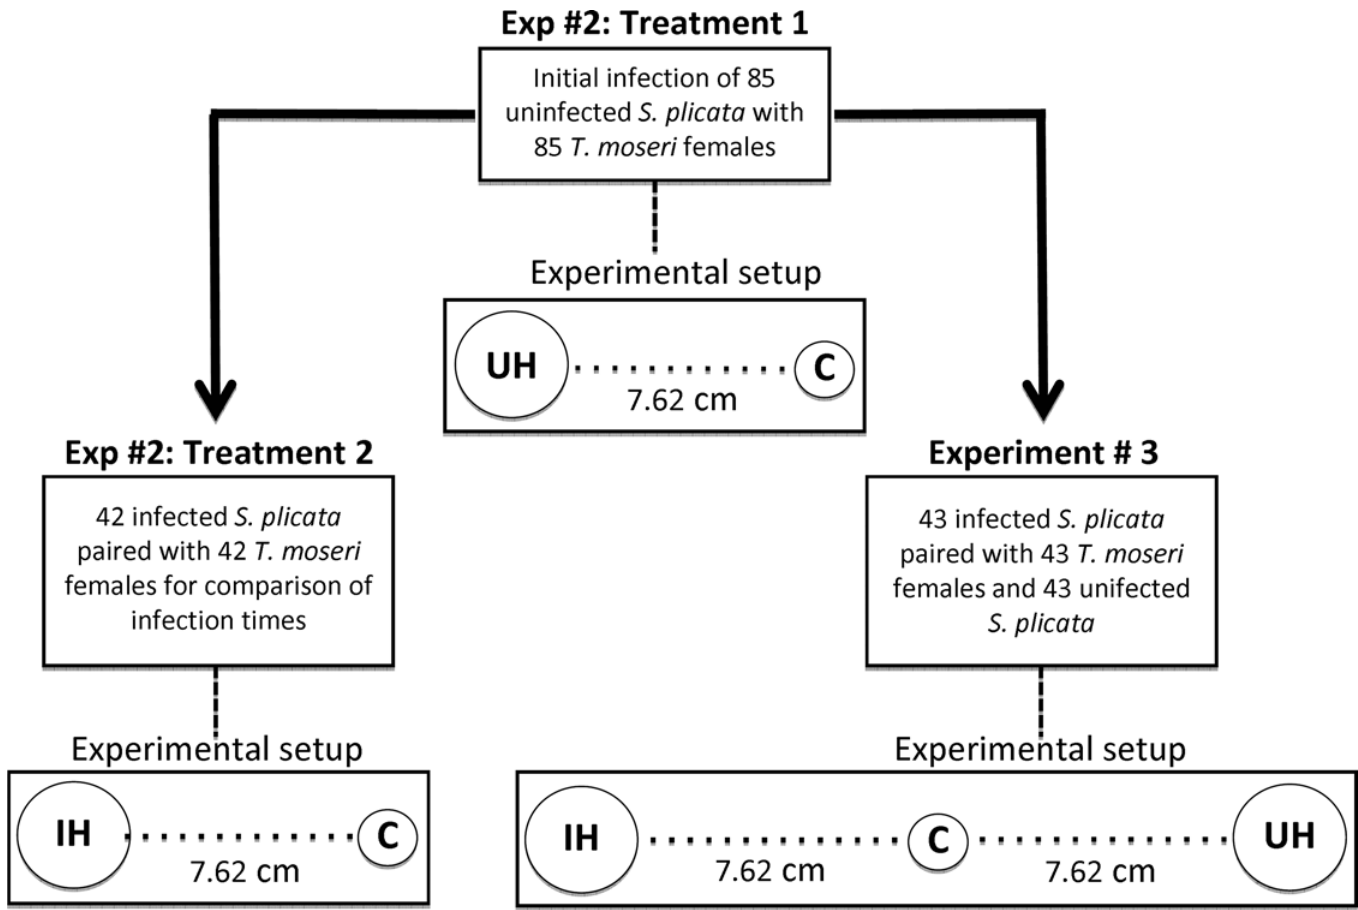
Fig 2. Flowchart of Experiments 2 and 3. Flowchart depicting the experimental design and setup of Experiments 2 and 3. Infected hosts generated in Experiment 2, Treatment 1 were used in Experiment 2, Treatment 2 and Experiment 3. Abbreviations UH, IH and C stand for uninfected host, infected host and crab,